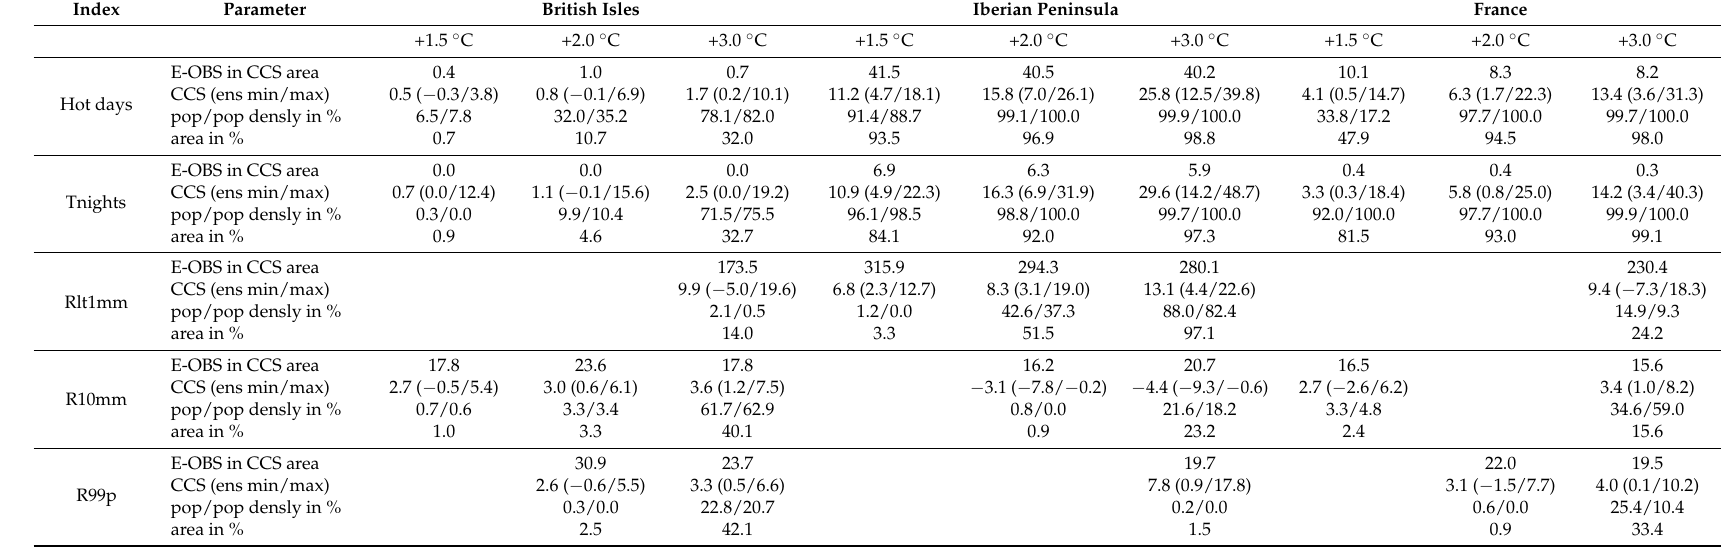
Table 4. Indices (refer to Table 1) and their parameters are shown for PRUDENCE regions (refer to Table 3) and GWLs +1.5 ◦ C, +2.0 ◦ C and 3.0 ◦ C. The parameter E-OBS indicates the reference value as represented by the E-OBS European observation data for each climate index under the present-day climate, averaged over the area in which significant climate change is projected under the respective GWL for the respective index. The parameter CCS (ens min/max) indicates the mean climate change signal and the ensemble minimum and maximum, averaged over the area in which significant climate change is projected under the respective GWL for the respective index. The parameters pop/pop densly indicate the percentage of the population and of the population living in densely populated areas, respectively, which is affected by a significant change in the respective climate index. Similarly, the parameter area indicates the percentage of the area that is affected by a significant change in the respective climate index. For more details refer to the